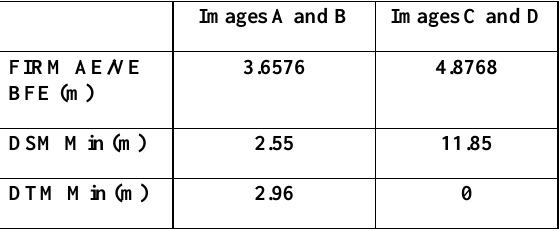
Table 2 – Minimum elevation for DSM and DTM for inundated road sections